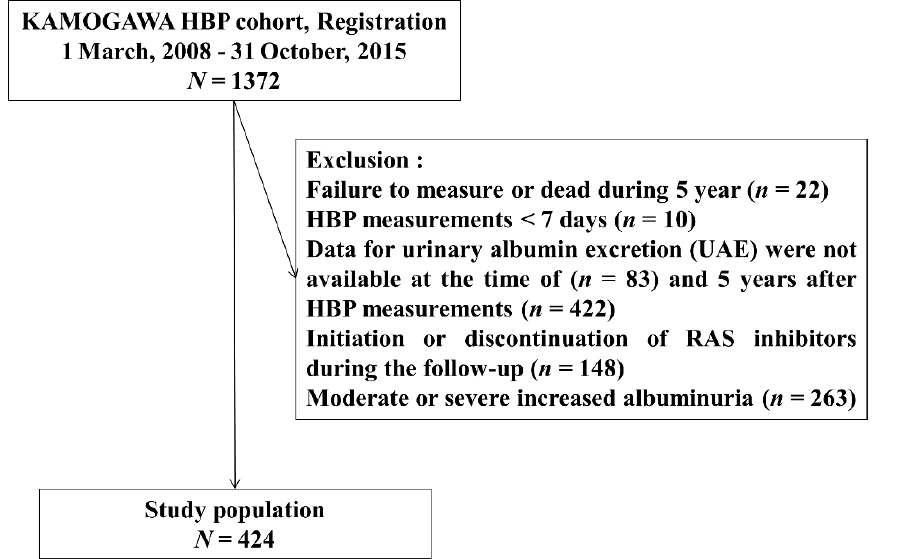
Figure 1. Study flow diagram for the registration of patients.